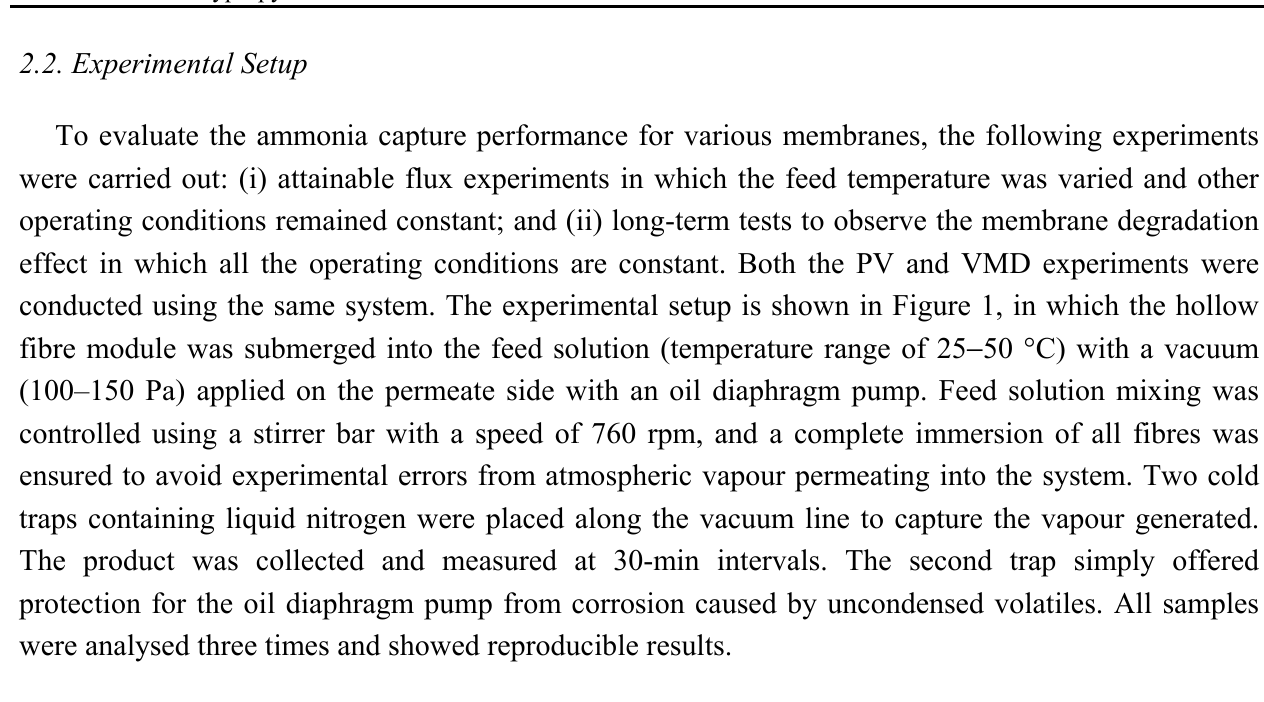
Figure 1. Experimental